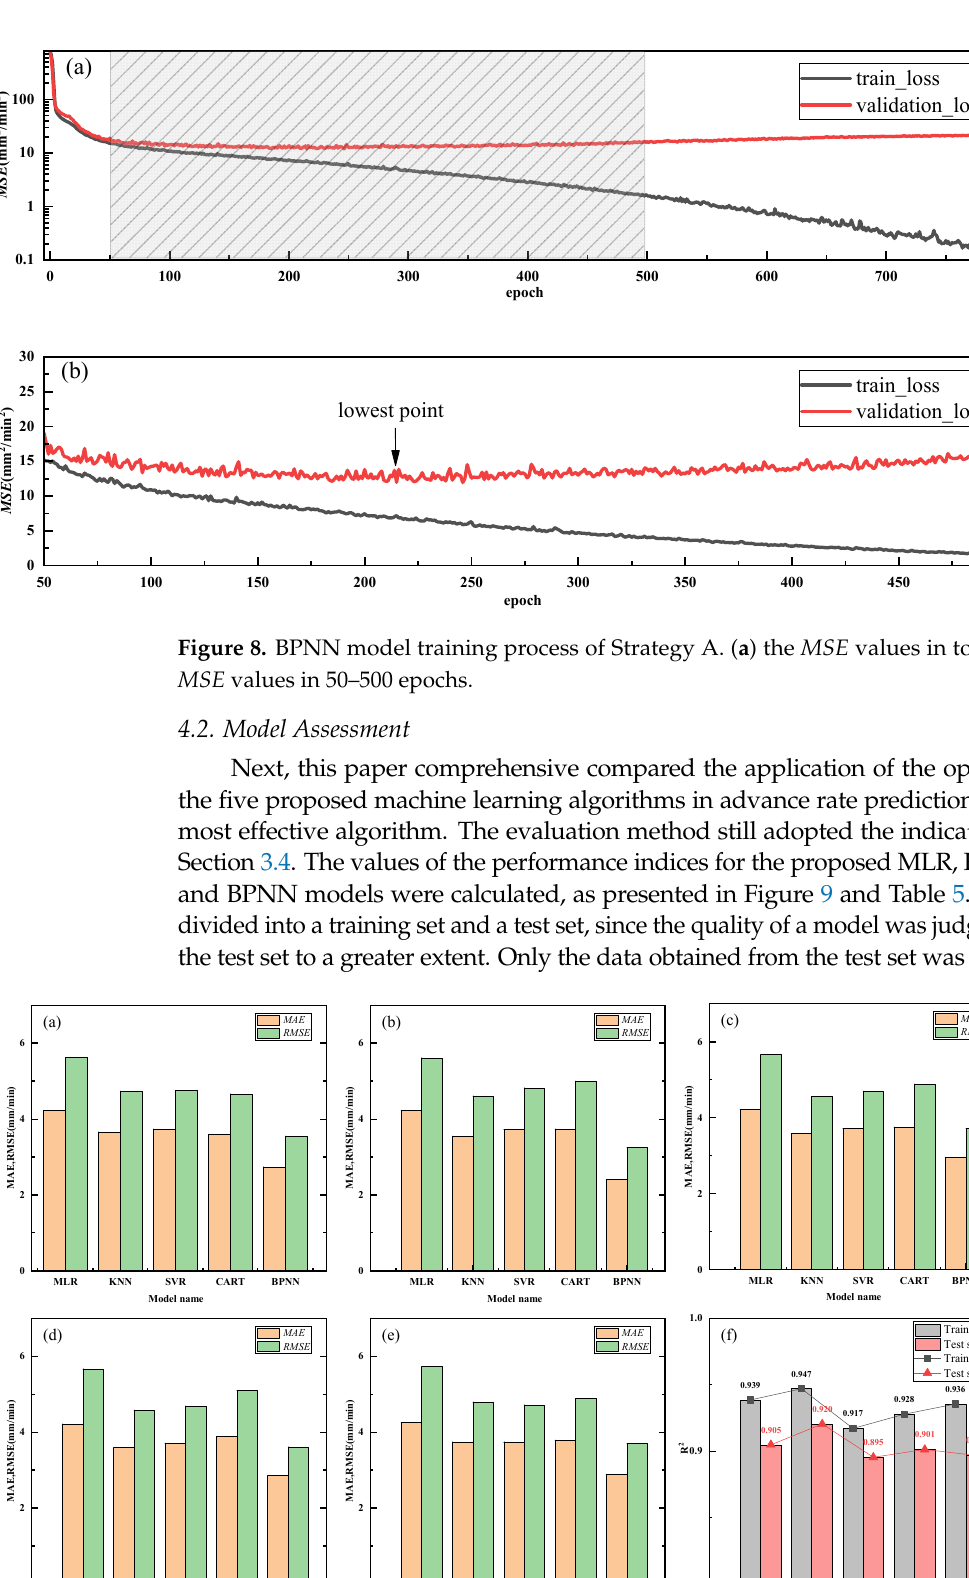
Figure 9. Evaluation result: ( a ) five models’ MAE and RMSE values in Strategy A; ( b ) five models’ MAE and RMSE values in Strategy B; ( c ) five models’ MAE and RMSE values in Strategy C; ( d ) five models’ MAE and RMSE values in Strategy D; ( e ) five models’ MAE and RMSE values in Strategy E; ( f ) BPNN models’ R 2 values in each strategy.